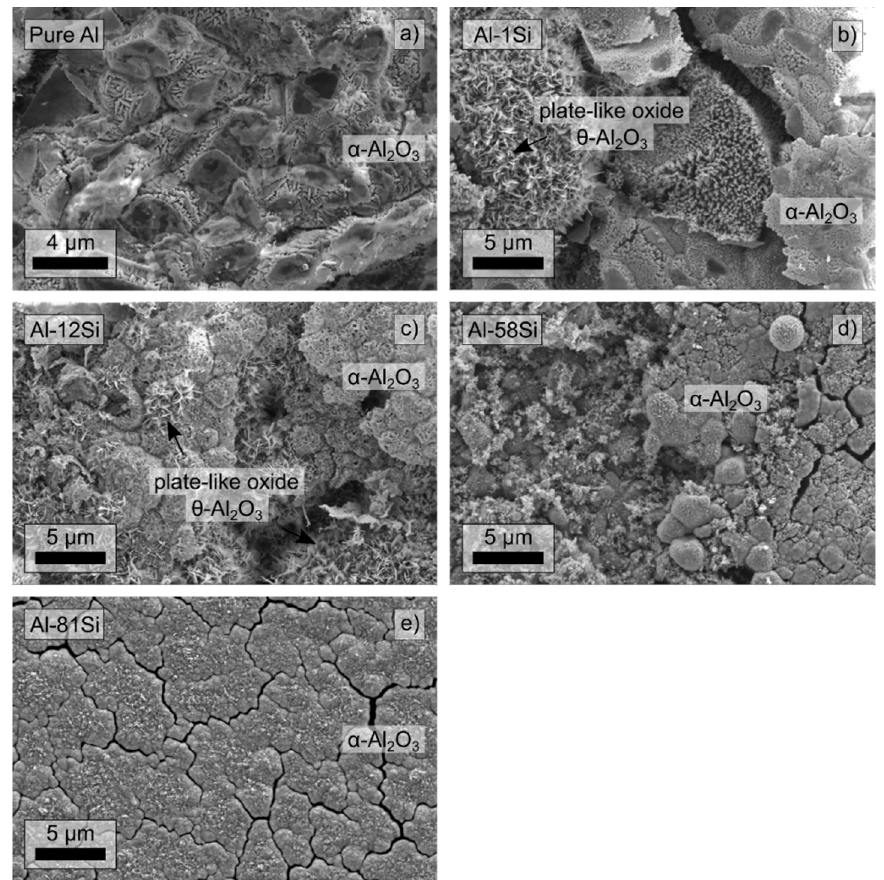
Figure 6. SEM images of the coatings in top view after 10 cycles of oxidation at 900 °C in lab air of ( a ) the pure Al coating, ( b ) the Al-1Si, ( c ) the Al-12Si, ( d ) the Al-58Si and ( e ) the Al-81Si coating (all in at.%)